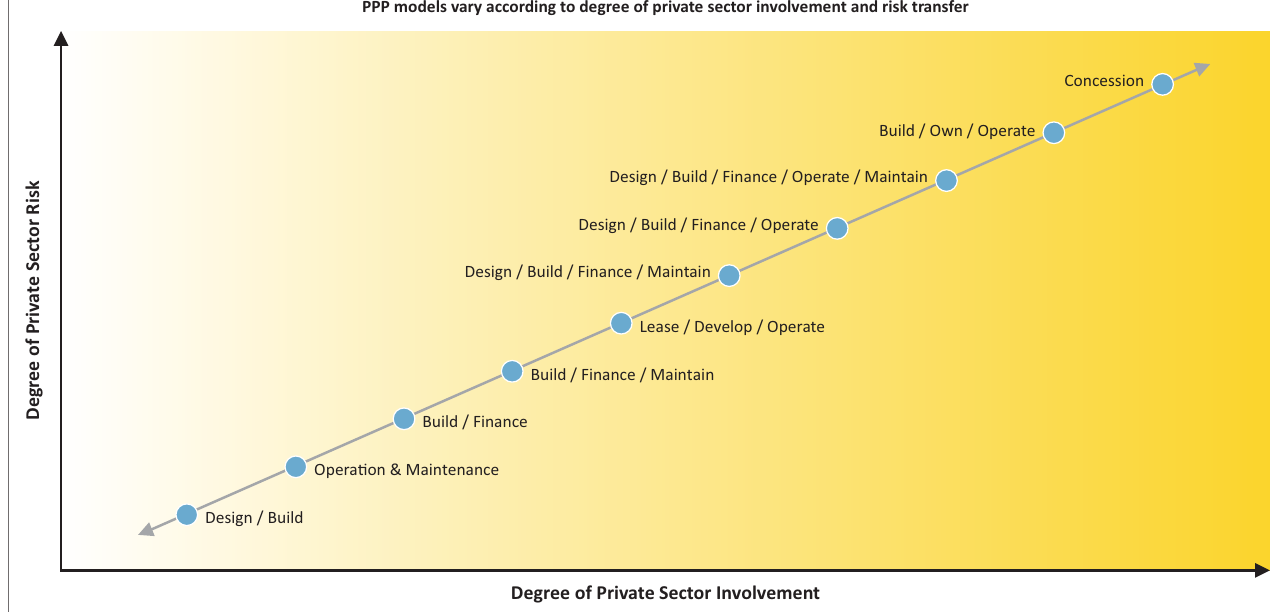
FIGURE 1: Public–private partnerships models with degree of private sector risk against private sector